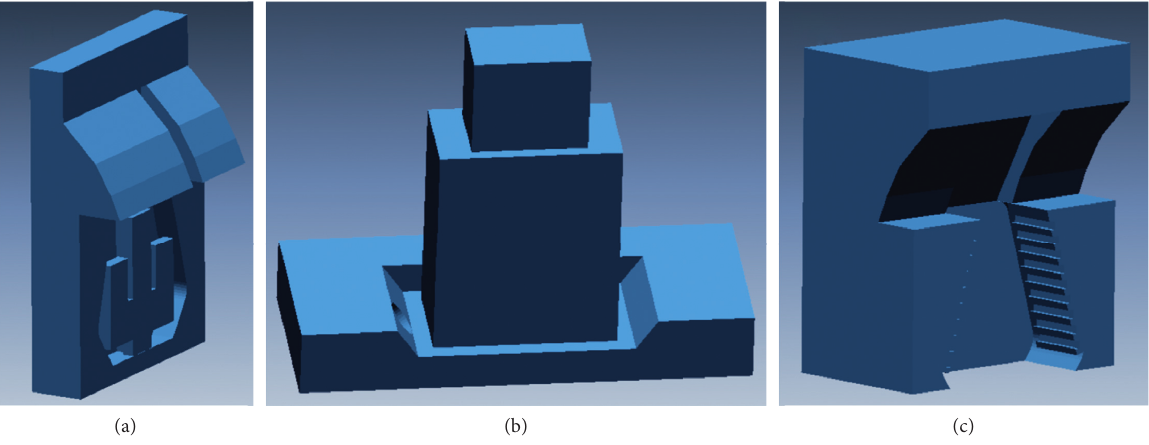
Figure 16: Computer aided mold design.